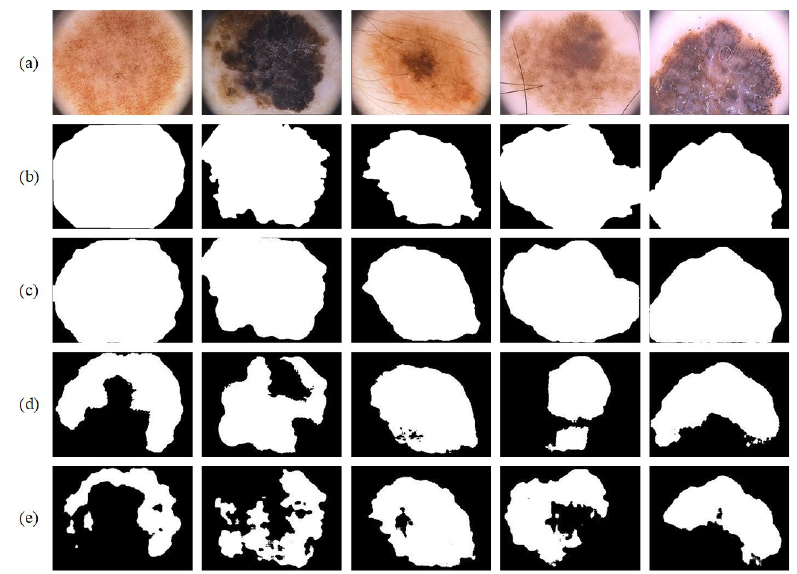
Figure 12. Segmentation results on the PH2 dataset: ( a ) original image; ( b ) ground truth; ( c ) segmen- tation result; ( d ) segmentation result from U-Net; and ( e ) segmentation result from